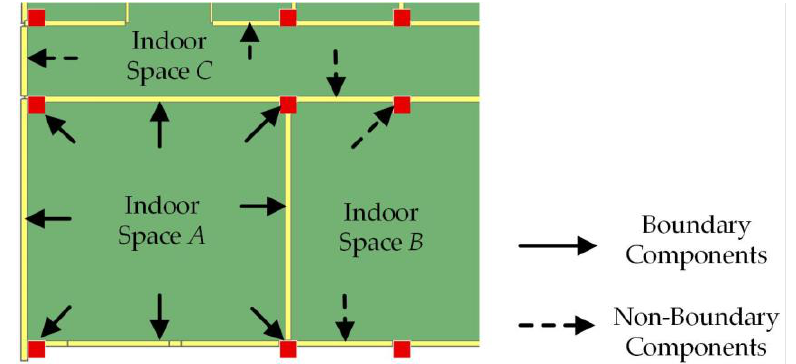
Figure 7. Construction of the boundary relationship .